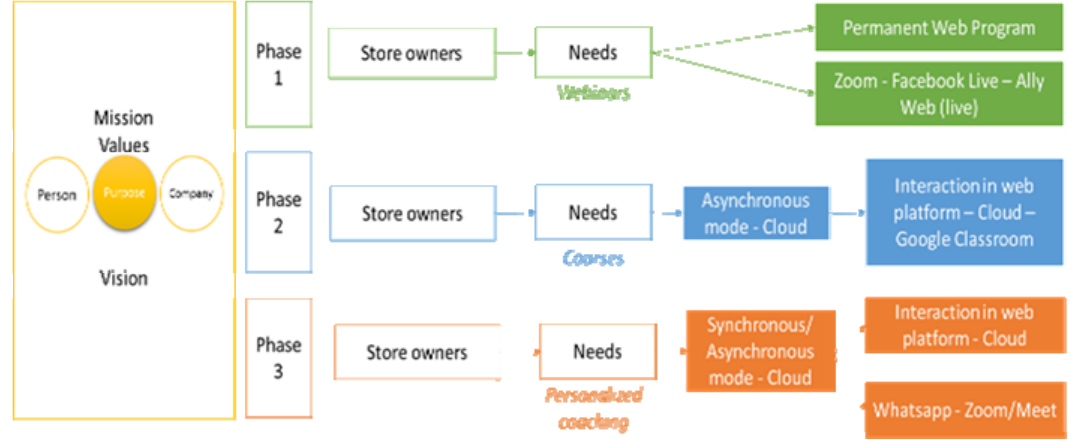
Figure 1. i4.0 Educational System (Ramírez, Rojas, and Albeiro,